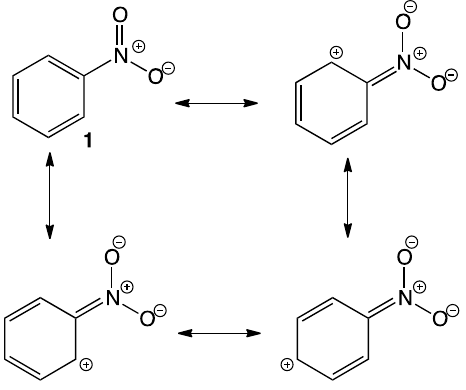
Figure 1. Resonance structures in nitrobenzene.